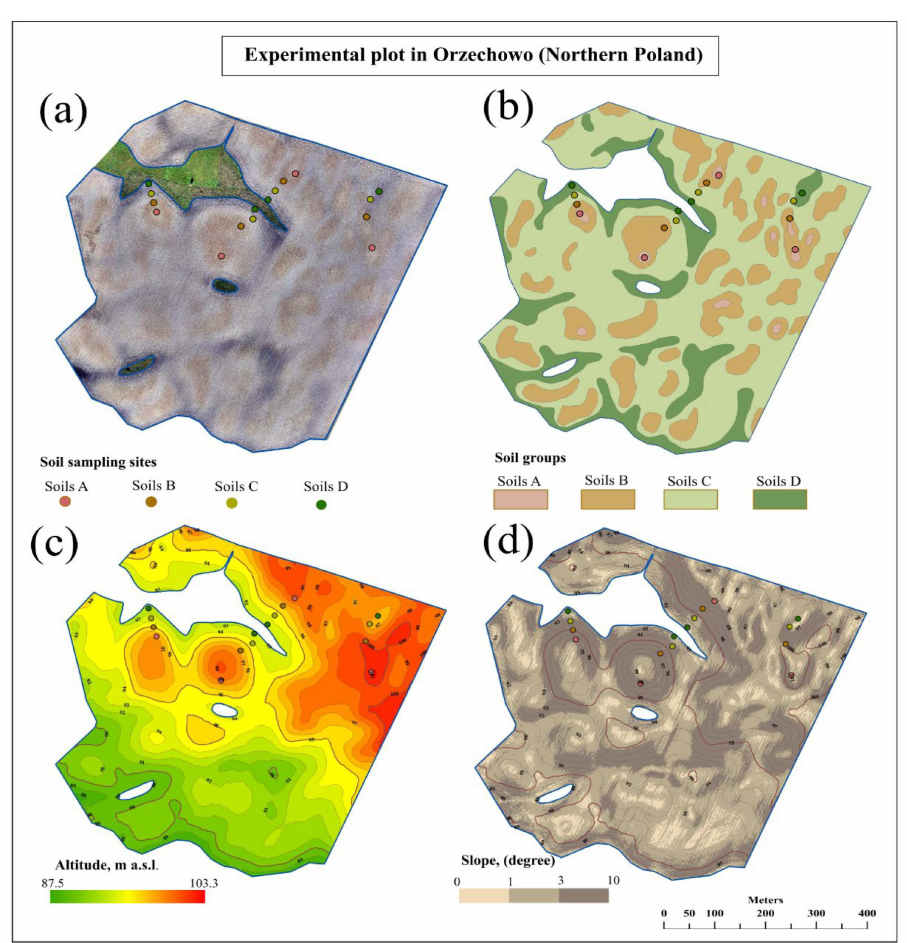
Figure 3. Characteristic of the experimental plot in Orzechowo (Northern Poland): ( a ) orthophoto- mosaic; ( b ) soil map; ( c ) relief of the territory; ( d ) slope